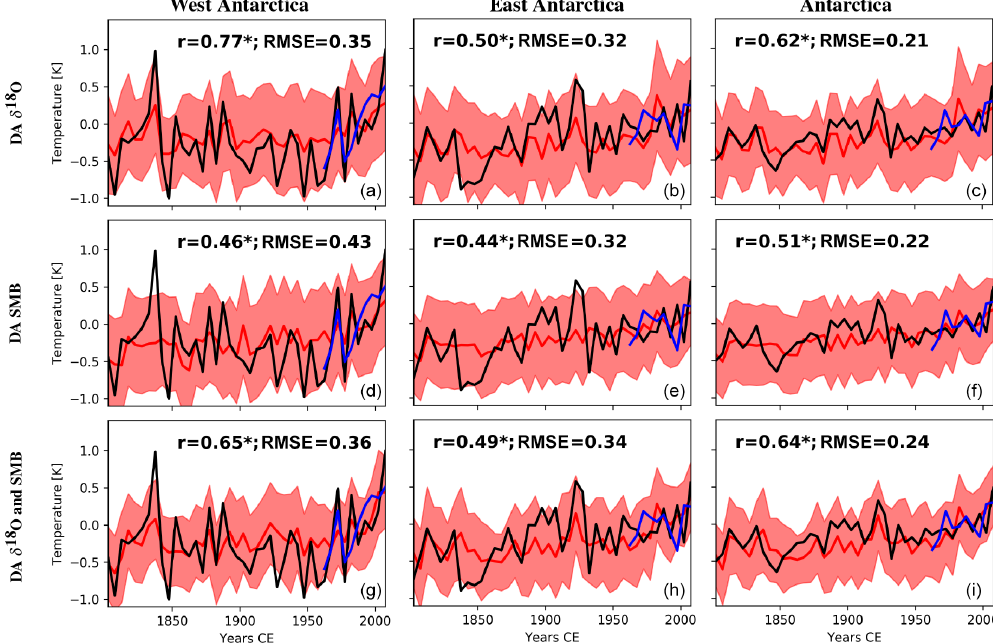
Figure 7. Reconstructed temperatures (5-year mean) for West Antarctica, East Antarctica, and Antarctica as a whole from the data assimi- lation experiment (red) using the iHadCM3 outputs and the δ 18 O (Stenni et al., 2017a) and SMB reconstructions (Thomas et al., 2017) as constraints in the data assimilation process. The period covered is 1800–2010. The surface air temperature reconstructions of Stenni et al. (2017a) are represented in black and those from Nicolas and Bromwich (2014a) are in blue. DA δ 18 O (a–c) is the data assimilation exper- iment using only the δ 18 O data to constrain the model while DA SMB (d–f) uses the SMB reconstruction and DA δ 18 O and SMB (g–i) use both. For each experiment and each region, the correlation ( r ) between the reconstruction based on ice cores (in black) and that based on data assimilation is computed (in red). The shaded areas represent ± 1 standard deviation of the model particles. Asterisks represent the statistically significant correlations ( p value < 0.05). Table 1. The 5-year mean correlations between the three surface air temperature reconstructions from data assimilation experiments using the ECHAM5–MPI-OM, ECHAM5-wiso, and iHadCM3 outputs and the statistical reconstruction of Stenni et al. (2017a), with the surface air temperature reconstructions from Nicolas and Bromwich (2014a) over the 1958–2010 period for West Antarctica, East Antarctica, and Antarctica as a whole. Asterisks represent statistically significant correlations ( p value < 0.10). DA stands for data assimilation. West Antarctica East Antarctica